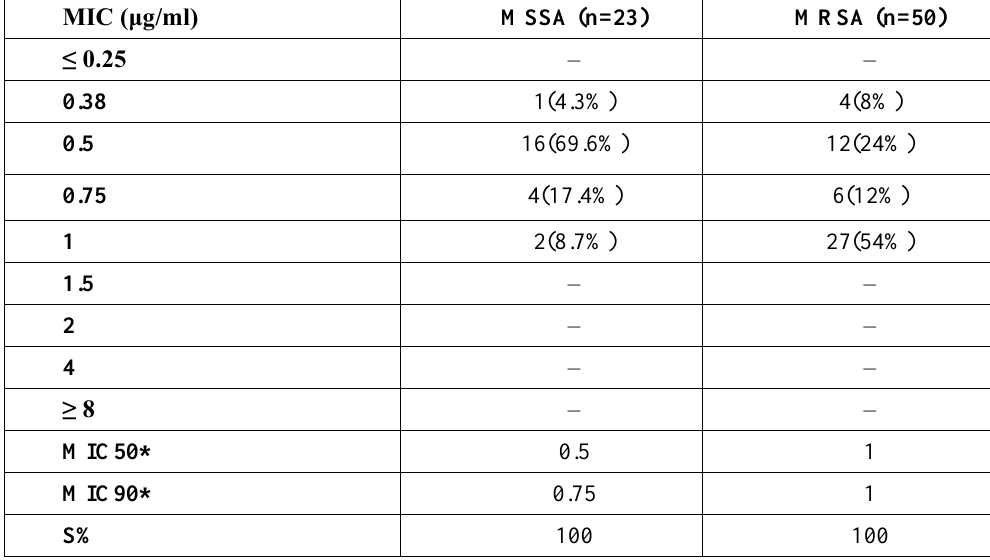
Table 4. Vancomycin MIC of S. aureus isolates by E-test.